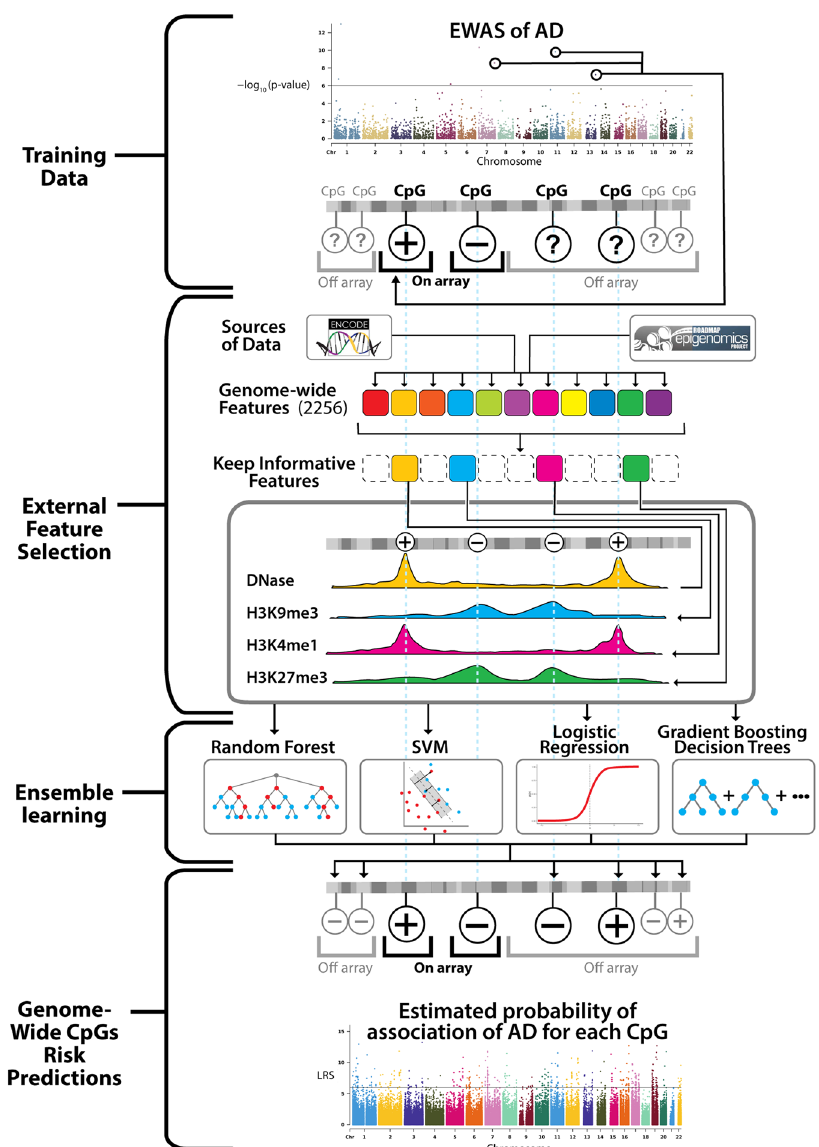
Fig. 1 Overview of EWASplus approach. The EWASplus procedure is composed of four major steps: (1) Training data collection from existing EWASs; (2) External feature (from sources such as ENCODE and Roadmap Epigenome consortia) selection; (3) Ensemble learning; and (4) Genome-wide CpGs risk prediction, in which trained ensemble learning model is applied genome-wide to score all CpGs. Table 1 Summary of performance evaluation of all six AD-related traits.